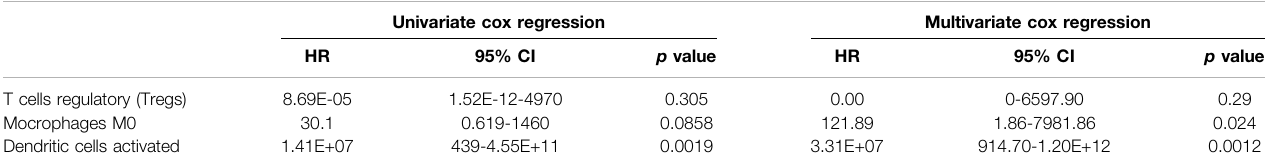
TABLE 1 | | Univariate and multivariate Cox regression analyses of three immune cells and overall survival of PTC